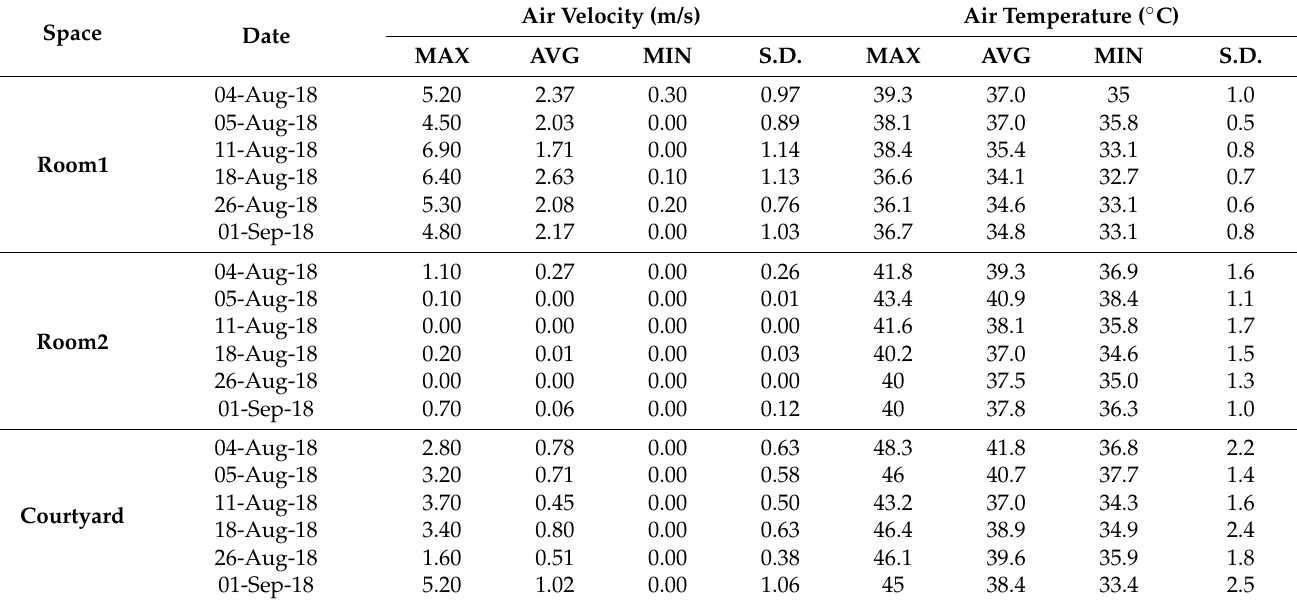
Table 7. Statistical comparisons between indoor and outdoor air velocity and temperature.